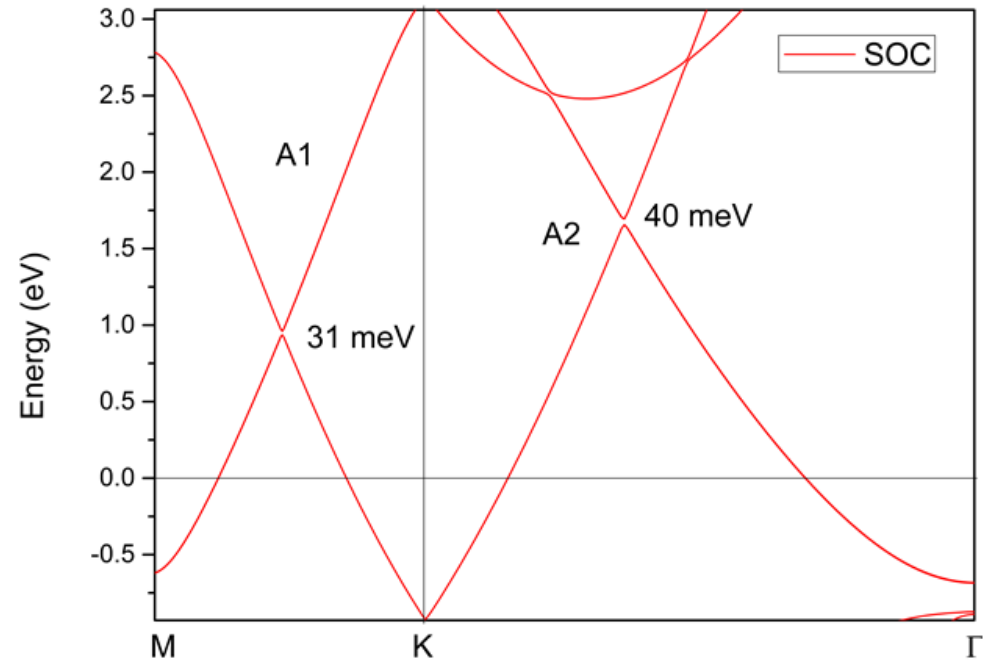
Figure 9. The band structure of YB 2 along the M-K- Γ paths calculated using GGA. The spin–orbit coupling e ff ect is taken into